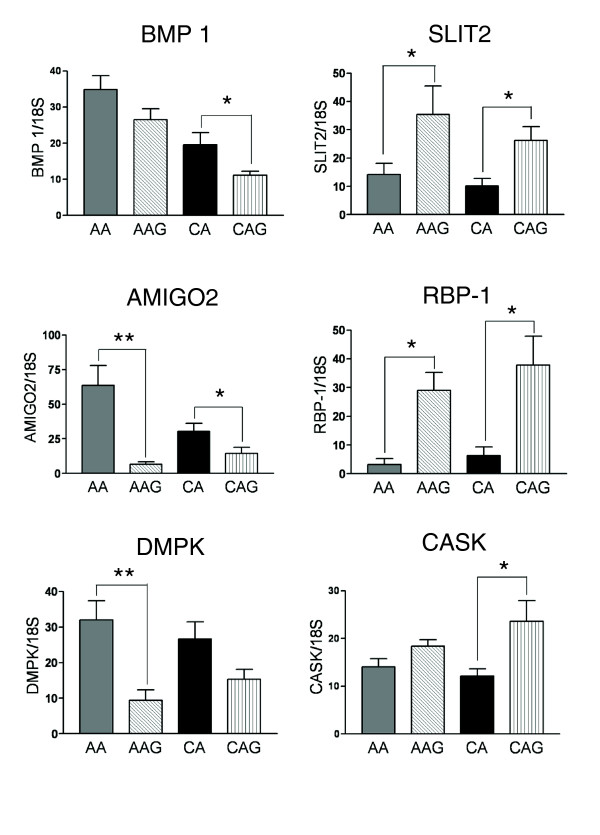
Glaucoma disease-associated genes differentially regulated in glaucomatous OHN astrocytes. Differential expression of six glaucoma disease associated genes (BMP1, AMIGO2, DMPK, SLIT2, RBP-1 and CASK) was validated by qRT-PCR in human ONH astrocytes. Genes were normalized to 18S. Graphical representation of the relative mRNA levels in normal and glaucomatous AA and normal and glaucomatous CA astrocytes (n = 6, two-tailed t-test). Asterisk indicates p < 0.05).